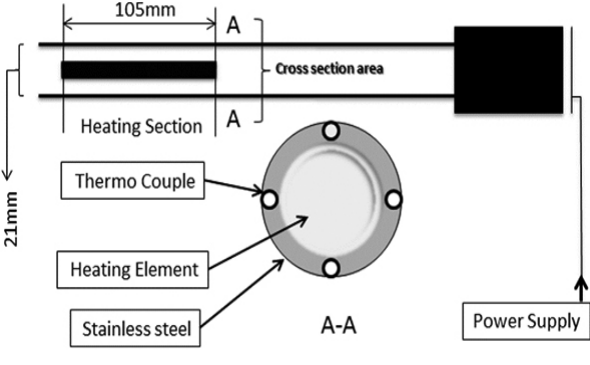
Fig. 2. Laboratory main heater details [14].